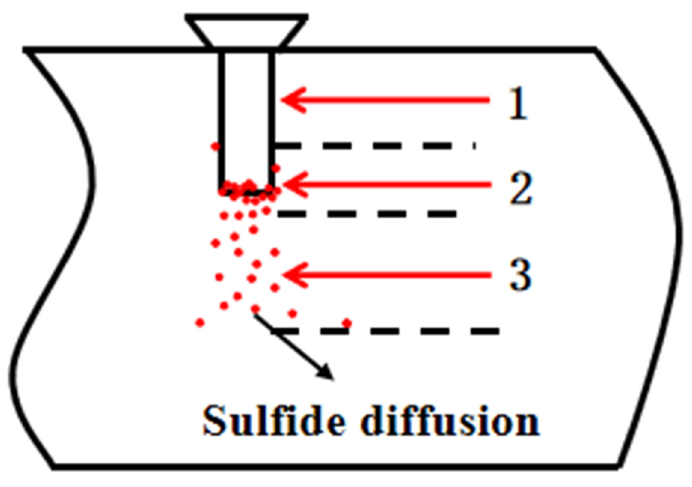
Figure 4. Sulfide diffusion during the nail shooting experiment [77].